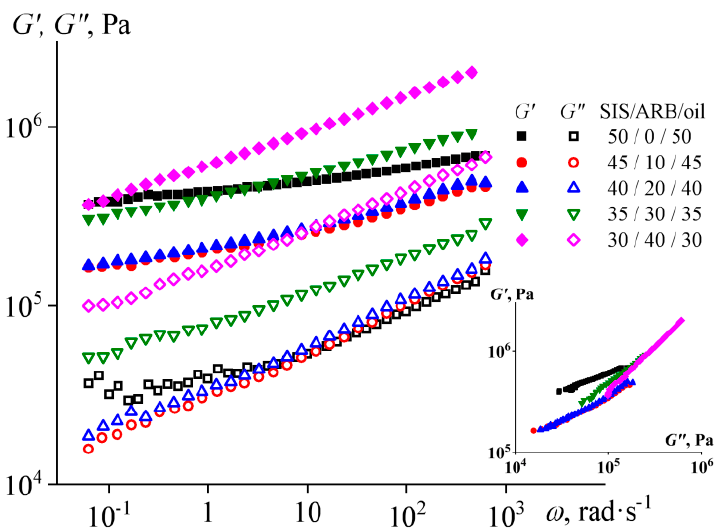
Figure 5. Frequency dependences of storage and loss moduli for triple mixtures containing different concentration of asphaltene/resin blend (ARB) and an equal ratio between styrene-isoprene-styrene triblock copolymer (SIS) and naphthenic oil at 25 °C. The insert shows the Cole–Cole plots. With the introduction of ARB, the cohesive strength of the mixture passes through a minimum corresponding to the composition with 20–30% of ARB (Table 2). The strength reduction is probably related to the plasticization of the mixture, which occurs due to the dissolution of the low molecular weight resins of ARB in the SIS. In the case of a high ARB content, the strength of the mixture conversely increases, which can be associated with the reinforcing effect of asphaltenes that do not dissolve in the polymer medium at their high content and act as a reinforcing phase. A similar situation was observed with epoxy resin, when the strength of the cured composite also passed through a minimum with increasing ARB content [82]. Table 2. Strength and adhesion characteristics of the mixtures with different concentration of asphal- tene/resin blend (ARB) and an equal ratio between styrene-isoprene-styrene triblock copolymer (SIS) and naphthenic oil.